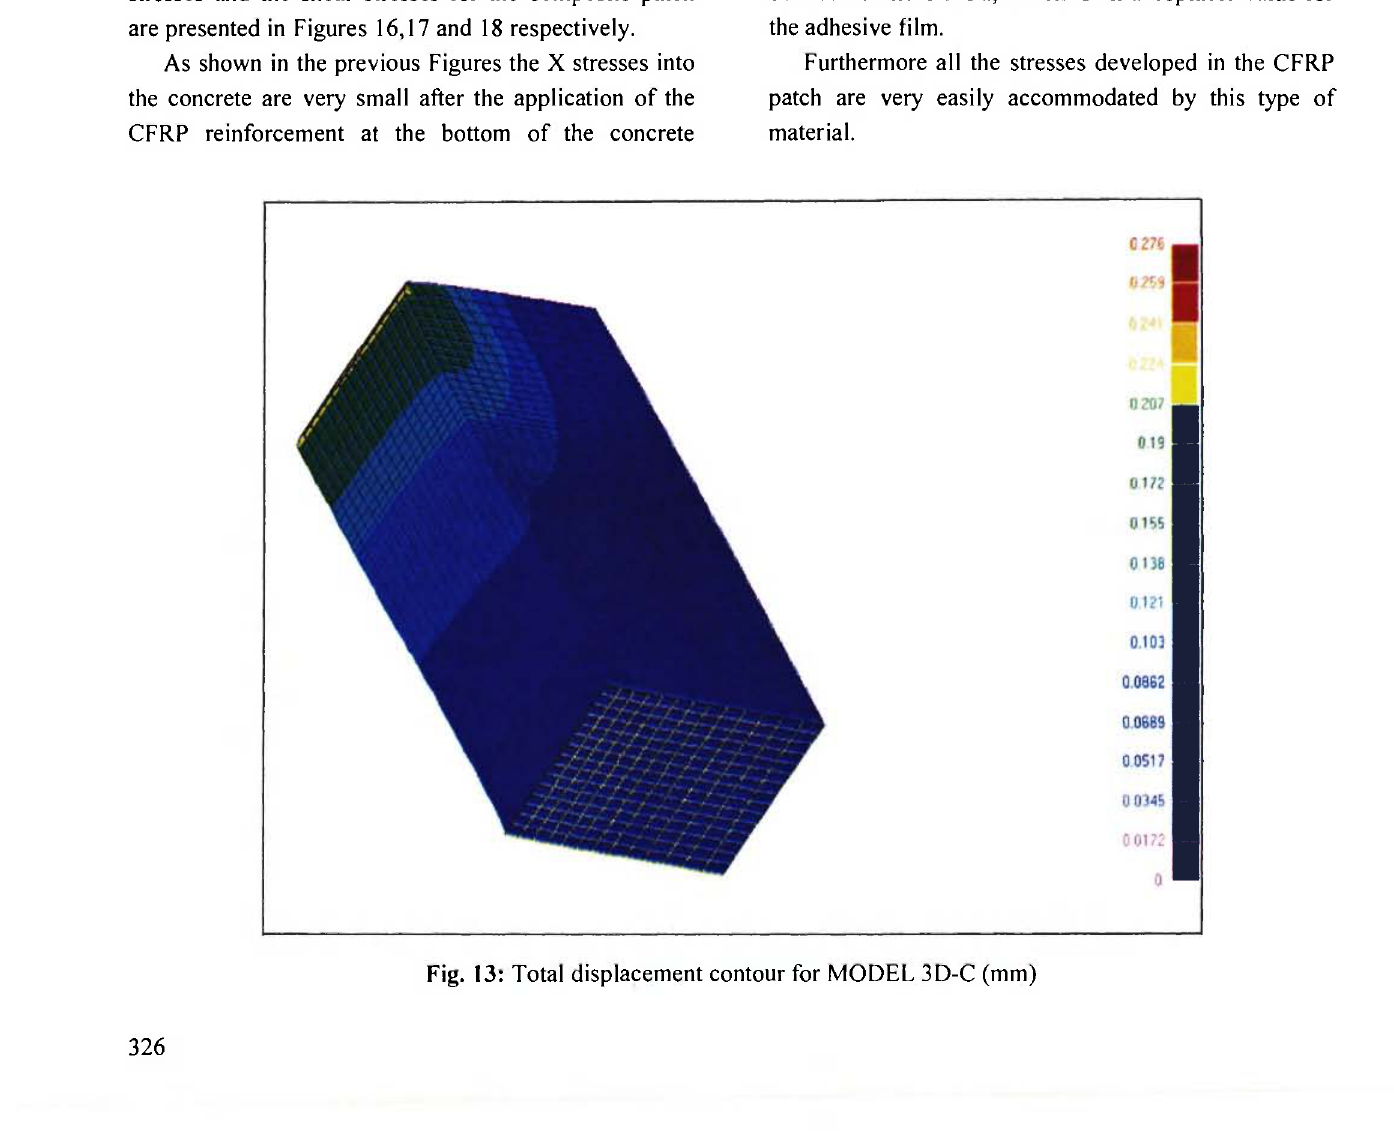
Fig. 13: Total displacement contour for MODEL 3D-C